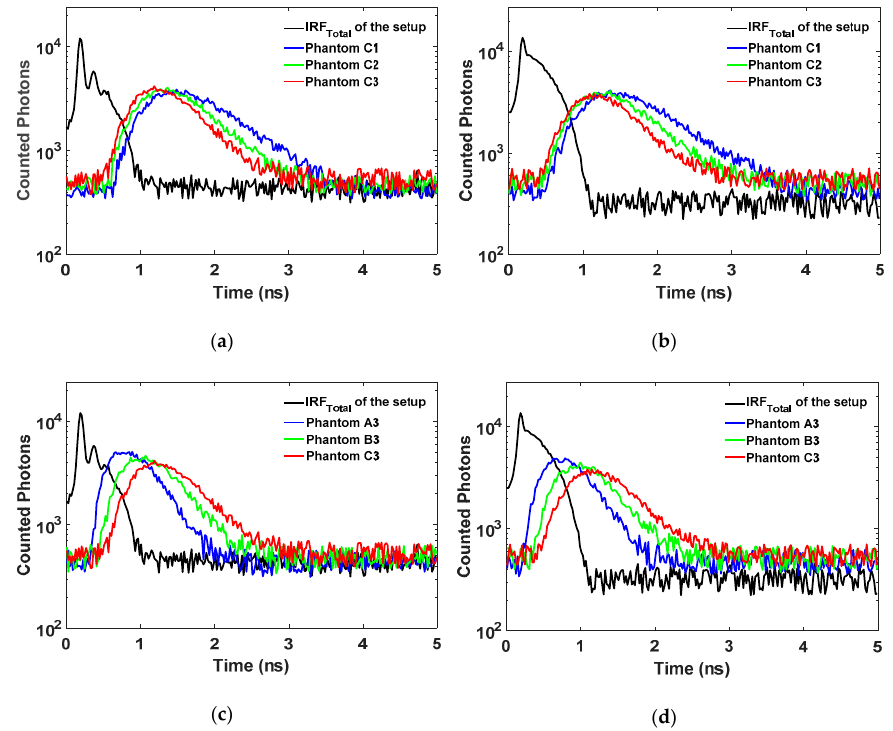
Figure 5. The IRF Total versus the measured DToF histograms for the phantoms: ( a ) high scattering phantoms with variable μ a at 685 nm; ( b ) high scattering phantoms with variable μ a at 830 nm; ( c ) high absorption phantoms with variable μ s ’ at 685 nm; and ( d ) high absorption phantoms with variable μ s ’ at 830 nm.